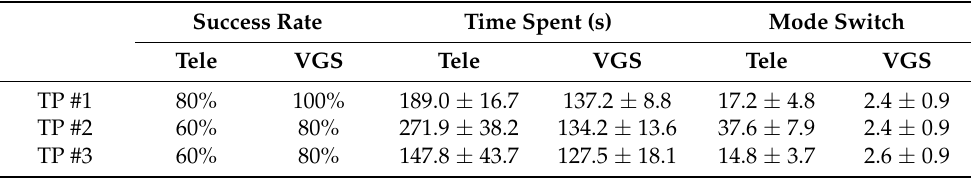
Table 6. Overall task performance during teleoperation and VGS